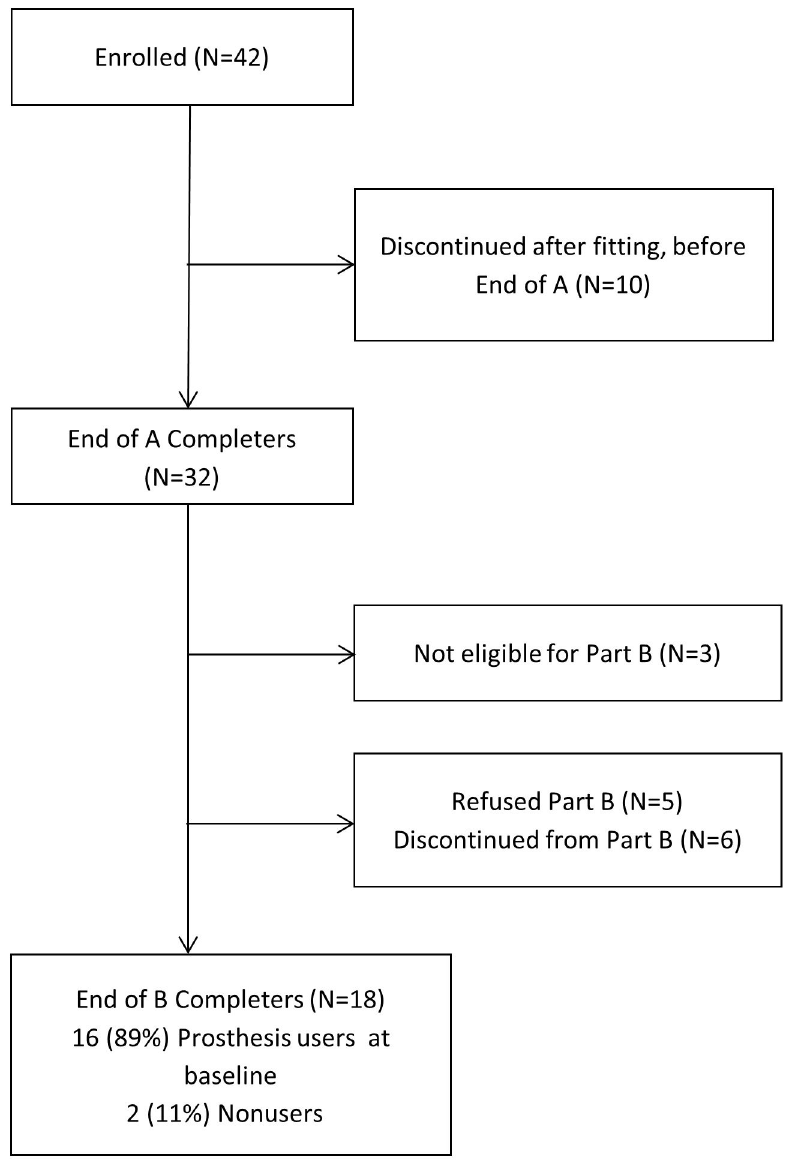
Fig 1. Study enrollment, attrition and